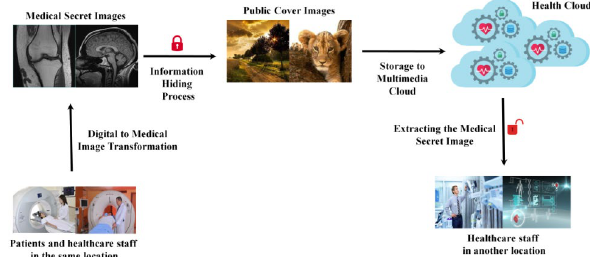
Fig. 1 . Transmission of the bio-medical image between